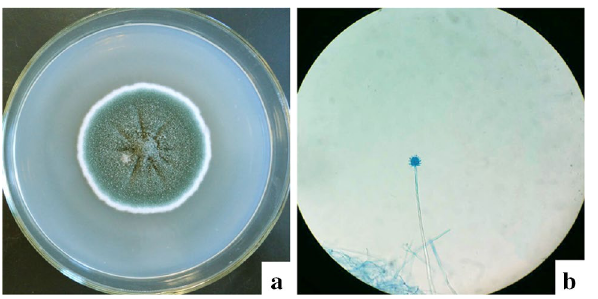
Figure 1. Morphology of Aspergillus sydowii . ( a ) Macroscopic morphology (28 ℃ , 7d); ( b ) microscopic morphology (× 400).